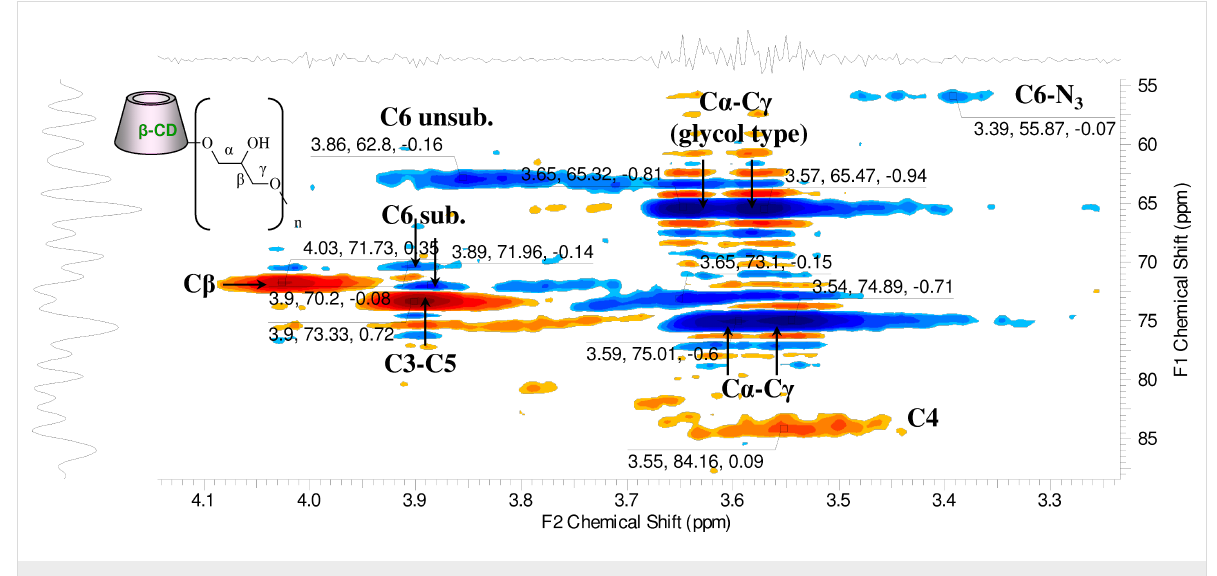
Figure 2: HSQC-DEPT spectrum of compound 1 with partial assignment.